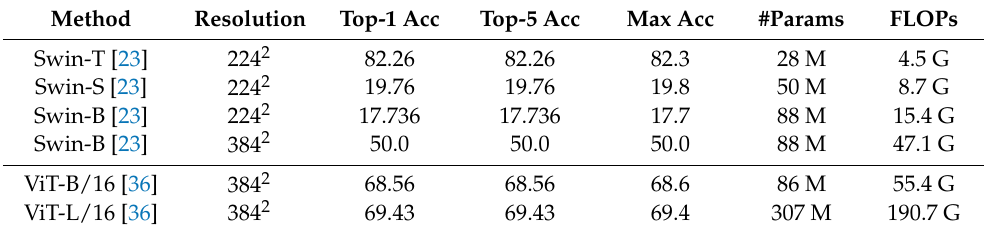
Table 2. Comparison of different backbones in regular training on LUNA16 classification.